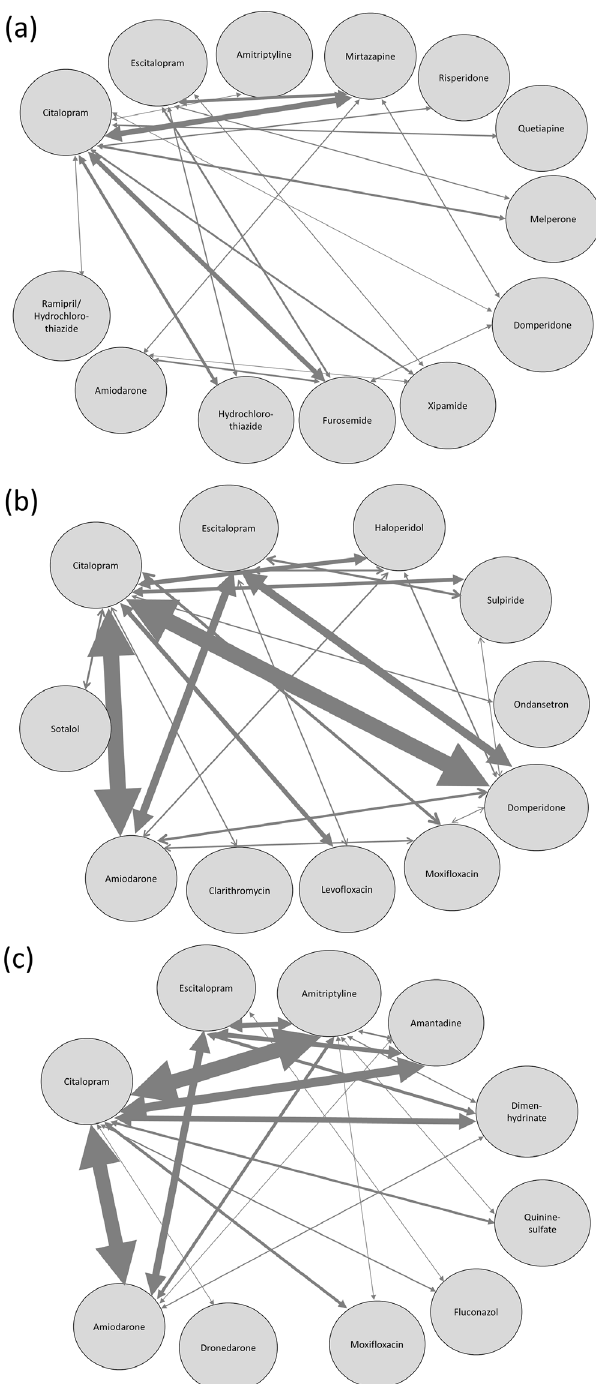
Fig 3. TOP 20 of the most common co-prescriptions in patients with QT-drugs associated with higher risk. (a) 20 most common co-prescriptions of two QT-drugs in patients with at least one High-risk-QT-drug and at least one further ALL-QT-drug, plotted as a net. For example, if a patient received 4 QT-drugs, all possible drug-drug prescriptions of two drugs were generated, in this case 6 possible combinations. The thickness of the arrow is proportional to the number of patients who received the respective combination. The precise percentages are listed in S3 Table. (b) Most common co-prescriptions of two QT-drugs in patients with (cid:1) 2 High-risk-QT-drugs. The 20 most common co-prescriptions of High-risk-QT-drugs accounted